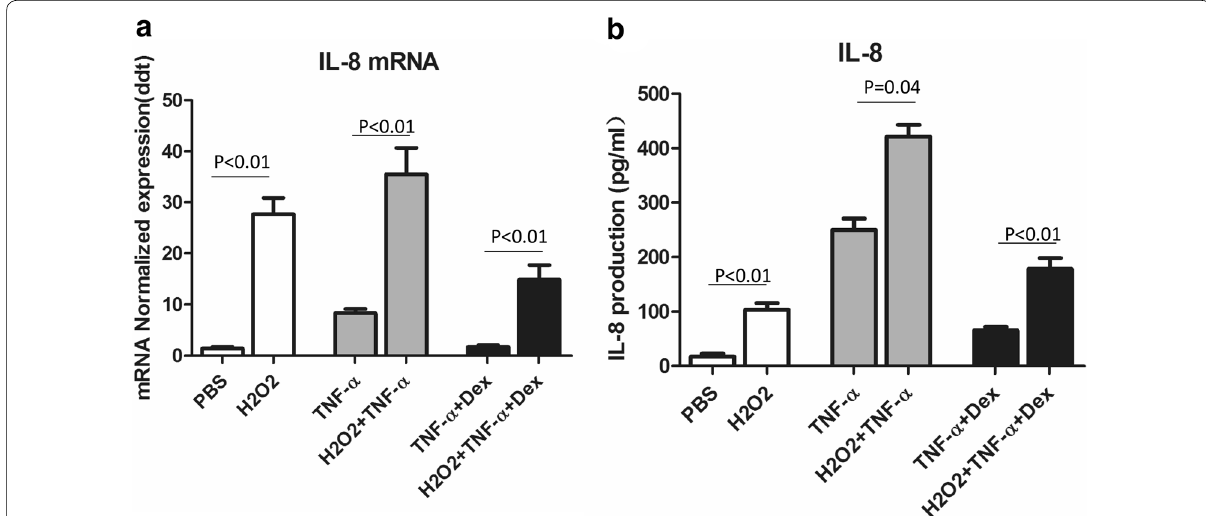
Fig. 4 Establishment of the H 2 O 2 -TNFα-U937 cell model to mimic the dexamethasone insensitivity of PBMCs in severe asthma. a IL-8 mRNA expression in cells treated with H 2 O 2 , TNFα treated with